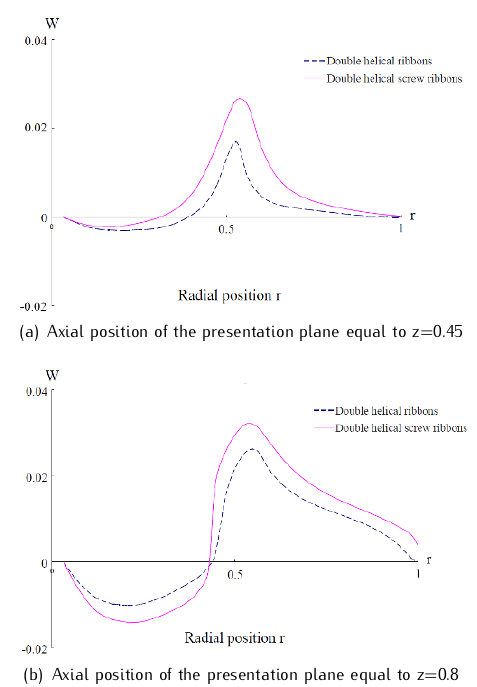
Figure 8. Radial profiles of the axial velocity